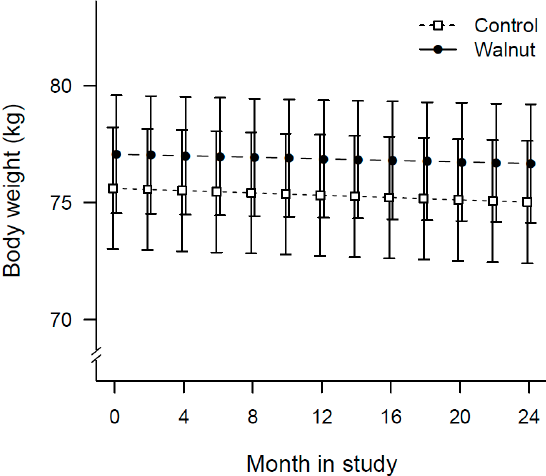
Figure 2. Plot of changes in mean body weight of participants over time by treatment